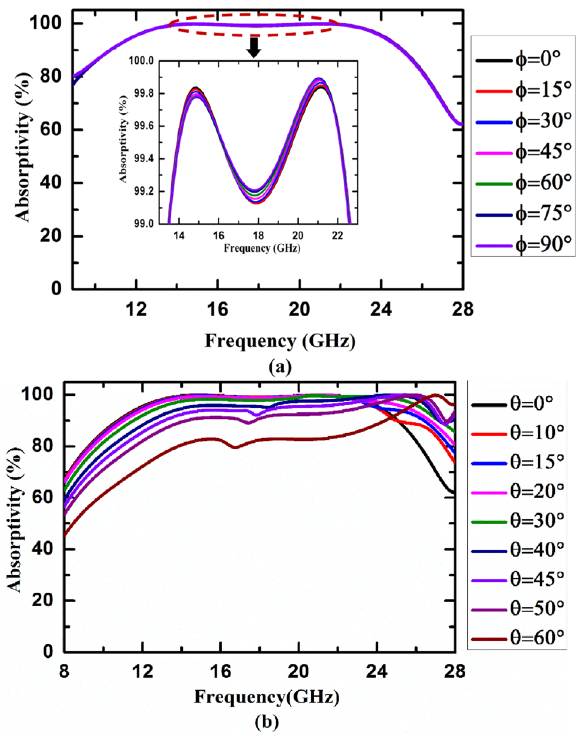
Figure 3. Absorption characteristic of the proposed metasurface absorber under different ( a ) polarization angle (ϕ) and ( b ) angle of incidence (θ) of TE-polarized wave.